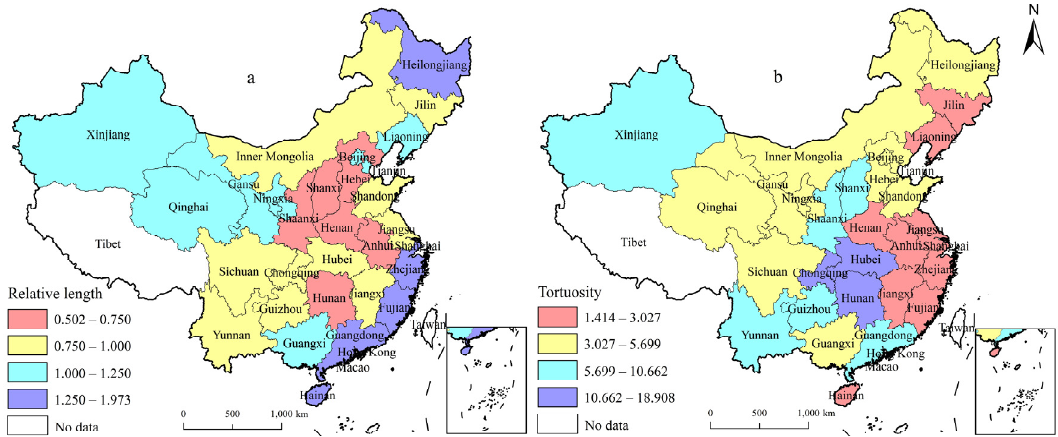
Figure 2. Spatial distributions of the ( a ) relative length and ( b ) tortuosity of rural energy poverty. The LISA time path relative length of rural energy poverty shows that there were 14 provinces with a relative length > 1 in 2000 ‒ 2015, accounting for 46.67% of the total, i.e., the local pattern of rural energy poverty exhibited a significant evolutionary law over time. During this period, the relative length showed a decreasing trend from east and west